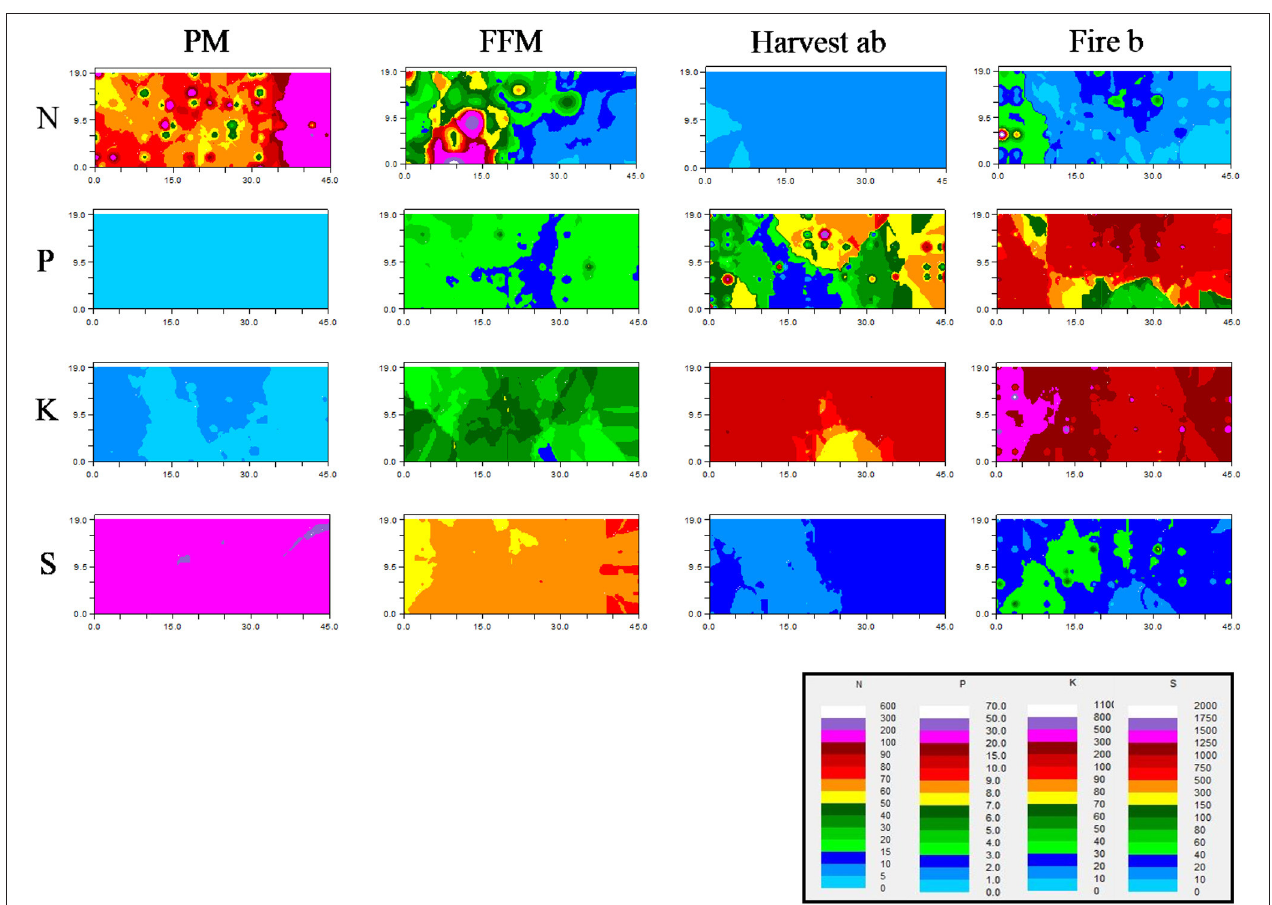
FIGURE 5 | Kriging maps of bioavailable N, P, K, and S based on fitted variogram models. Modeled spatial nutrient bioavailability is expressed in µ g 10 cm − 2 . Peat mineral-mix (PM), forest floor mineral-mix (FFM), Harvest ab by timber harvesting disturbed a/b ecosite, Fire b a by forest fire disturbed type b ecosite. TIN reported as sum of NO − 3 and NH + 4 ; P as equivalent of H 2 PO − 4 , HPO 2 − 4 ; K as equivalent of K + ; S as equivalent of SO 2 − 4 .